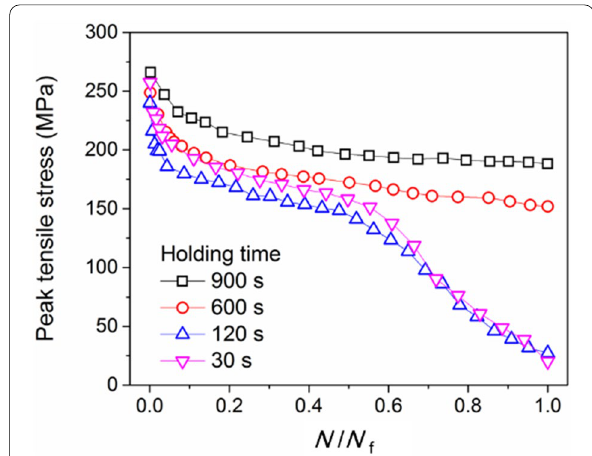
Figure 6 Cyclic softening curves during creep-fatigue (CF) tests at different dwell